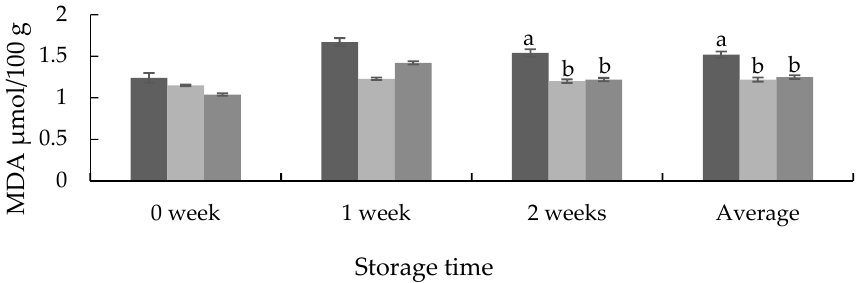
Figure 1. Effects of fermented S. japonica and D. morbifera (FSJ-DM) on the malondialdehyde (MDA) values in gluteus medius muscle from Korean native black goats. Data are presented as mean ± SE. a, b Values with different superscripts in the same storage period differ significantly ( p < 0.05). On an average (0–2 weeks) and after 1 week of storage, the pH of KNBG meat was significantly lowered in the 1.0% FSJ-DM supplemented group ( p < 0.05). However, no differences were observed after 0 and 2 weeks of storage (Figure 2).